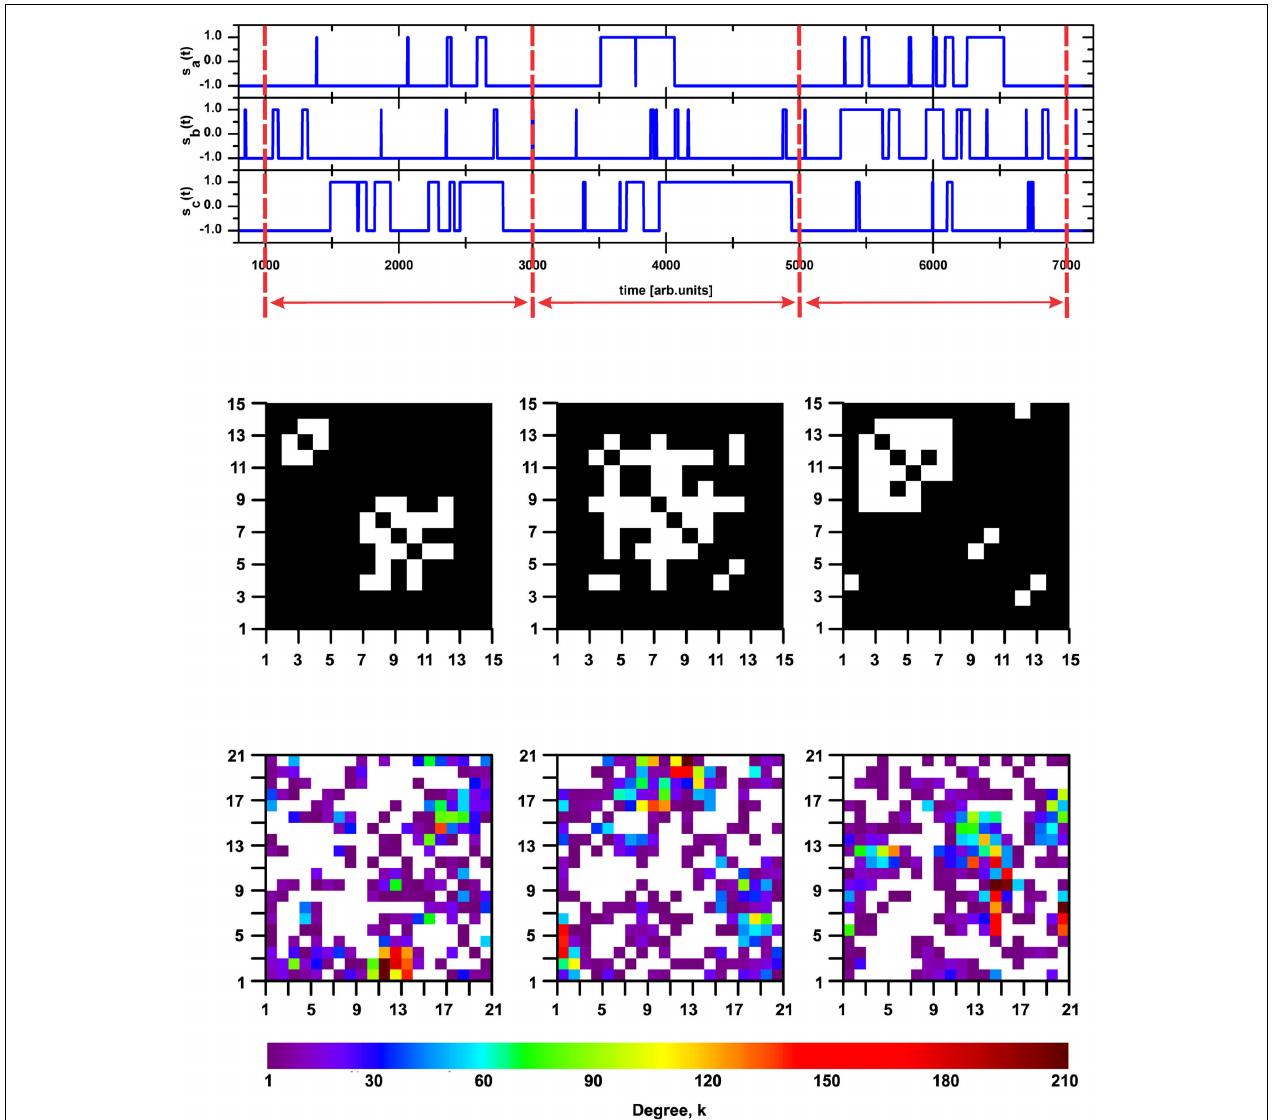
FIGURE 2 | Consecutive steps that lead to the dynamical topology. Top panel shows time evolution of three randomly selected nodes of the square lattice. Arrows denote time intervals over which the correlation index of Eq. 4 is calculated. Middle panel illustrates the fragment of an adjacency matrix of the dynamically created network. It originates by the application of a threshold Θ to the values of correlation all nodes of square lattice. Full size of this adjacency matrix is N 2 × N 2 .White squares denote the case when the correlation between unit i and j is larger than threshold and they correspond to the link between node i and j in the dynamical network. Lower panel